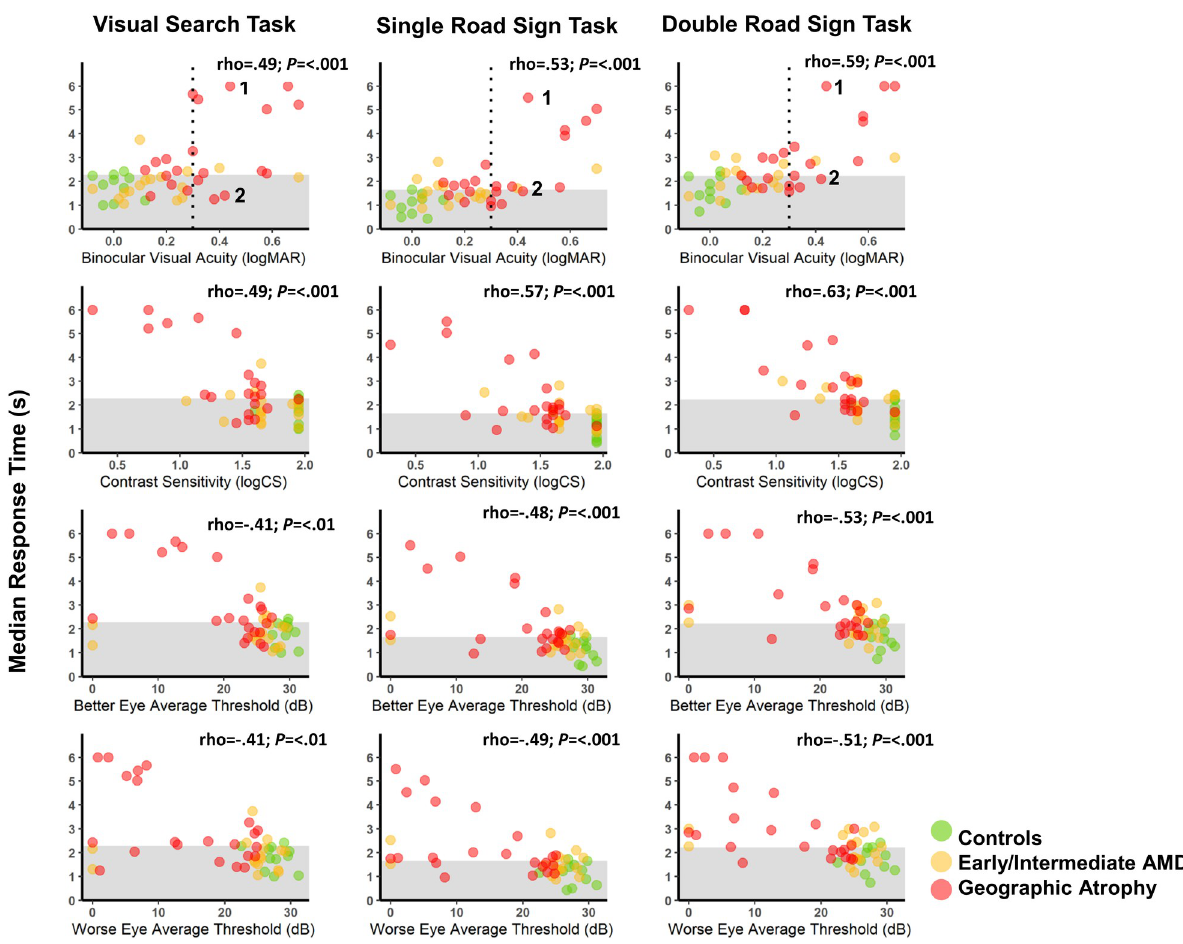
Fig 4. Scatterplots showing relationship between median response time and clinical and demographic variables. Comparing measures of visual function to the median response times (seconds) of the three tasks with respect to the normative limit set at 90% from the control group’s results (shaded area). The average thresholds are calculated from microperimetry data. The dotted, vertical line on the top row of plots shows the minimum visual acuity required to legally drive in the UK (0.3logMAR). Two case studies have been labelled on the visual acuity plots (1–2) to be further